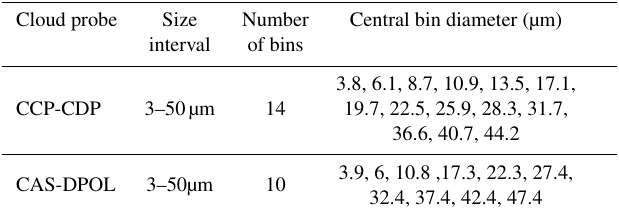
Table 1. Cloud probe size intervals and central bin diameters during HALO